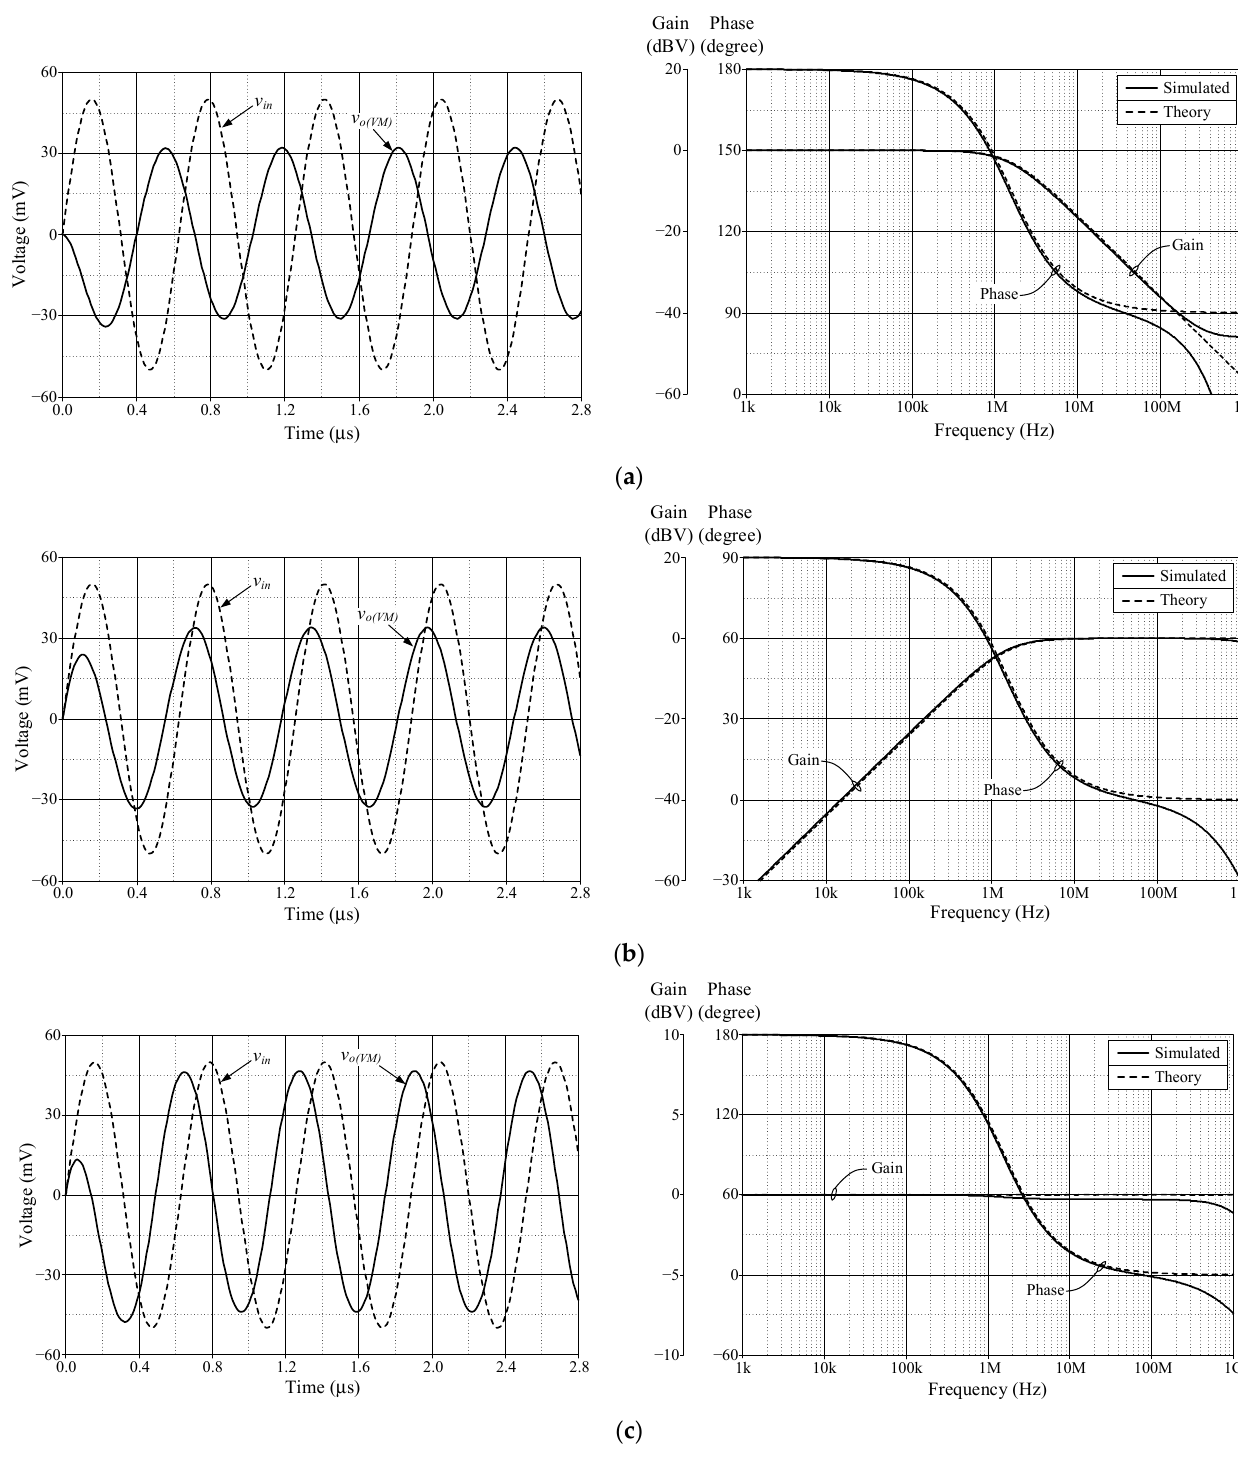
Figure 5. Simulated time and frequency responses of the proposed VM filter: ( a ) LP; ( b ) HP; and ( c )